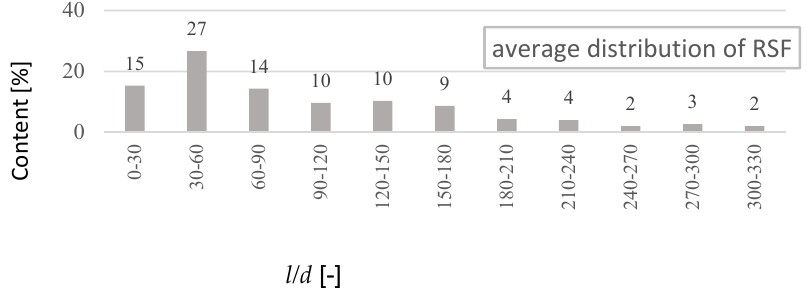
Figure 5. The average percentage of RSF diameter distribution.